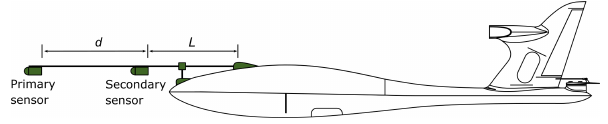
Figure 6. Side view of the final front-boom-mounted setup.